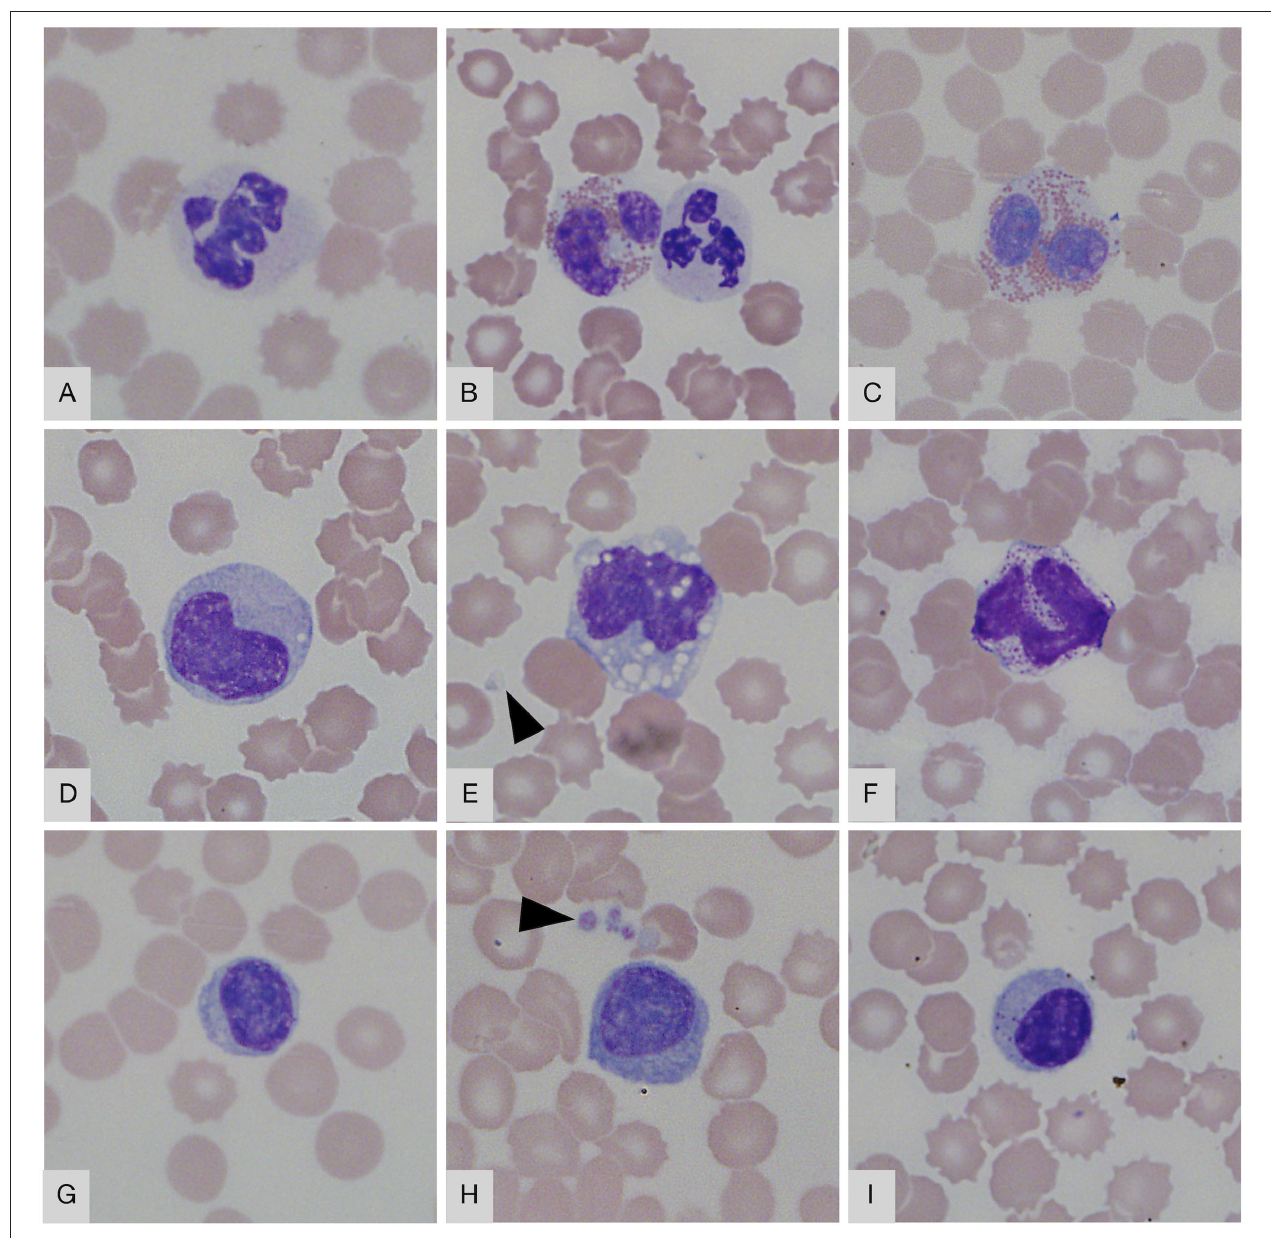
FIGURE 2 | Blood smear images from Temminck’s ground pangolin. (A) neutrophil; (B) neutrophil (right) and eosinophil (left); (C) eosinophil; (D) monocyte; (E) monocyte with vacuoles; (F) basophil; (G) small lymphocyte; (H) reactive lymphocyte; (I) granular lymphocyte. Platelets are visible in (E,H) (arrowheads). Wright-Giemsa, × 1,000